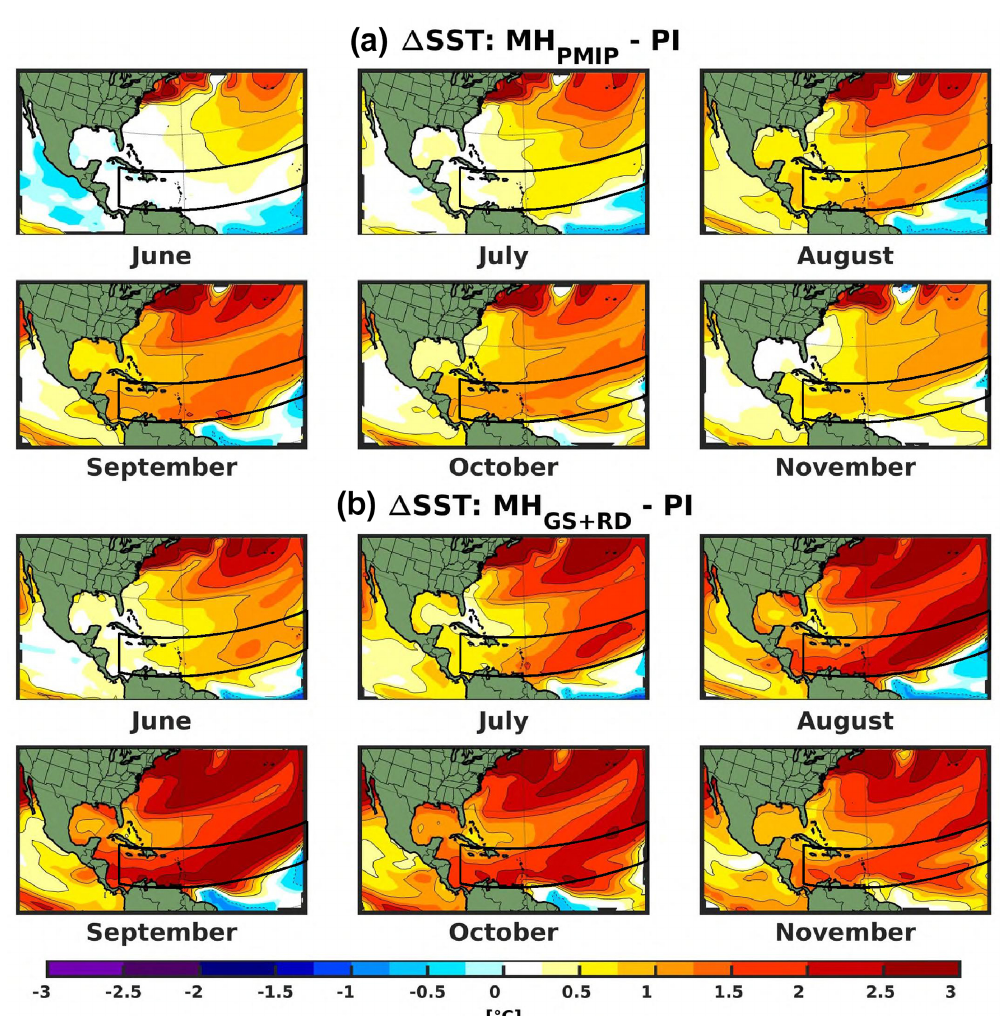
Figure A11. Monthly mean changes in climatological SSTs for the (a) MH PMIP and (b) MH GS + RD experiments relative to the PI exper- iment. The black box shows the approximate present-day MDR. Only values that are significantly different at the 5% level using a local (grid-point) t test are shaded. The contour lines follow the color-bar scale (dashed, negative anomalies; solid, positive anomalies); the 0 line is omitted for